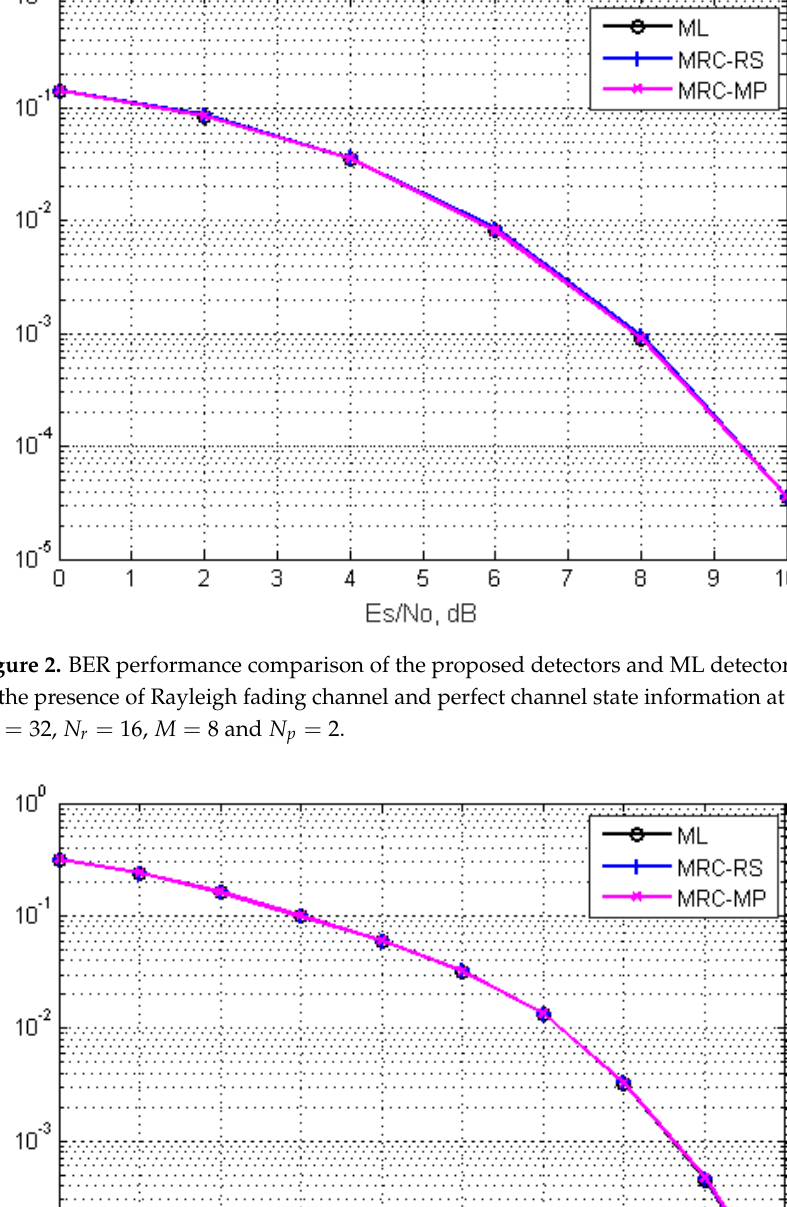
Figure 4. Average number of TACs detected by MRC-RS and MRC-MP algorithms for a GSM sys- tem with